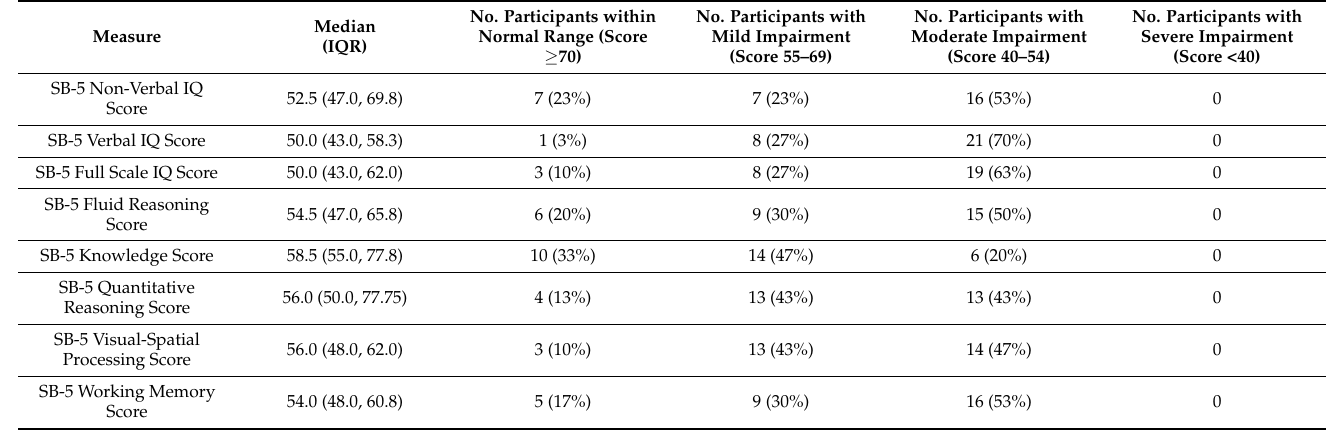
Table 5. Stanford Binet-5 (SB-5) cognitive data for participants ( n = 30).